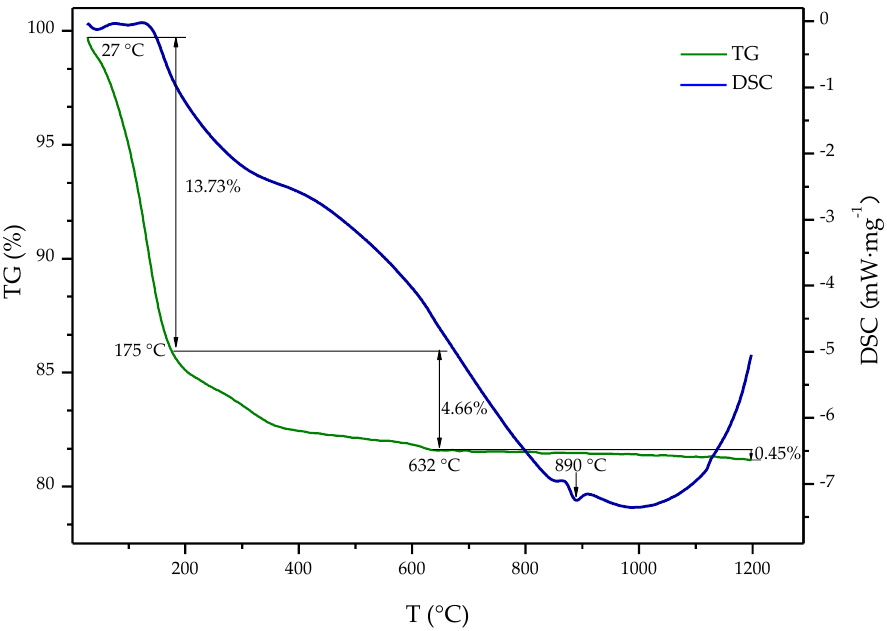
Figure 10. Thermogravimetry-differential scanning calorimetry (TG-DSC) curves of No. 20 from room temperature up to 1200 ◦ C.